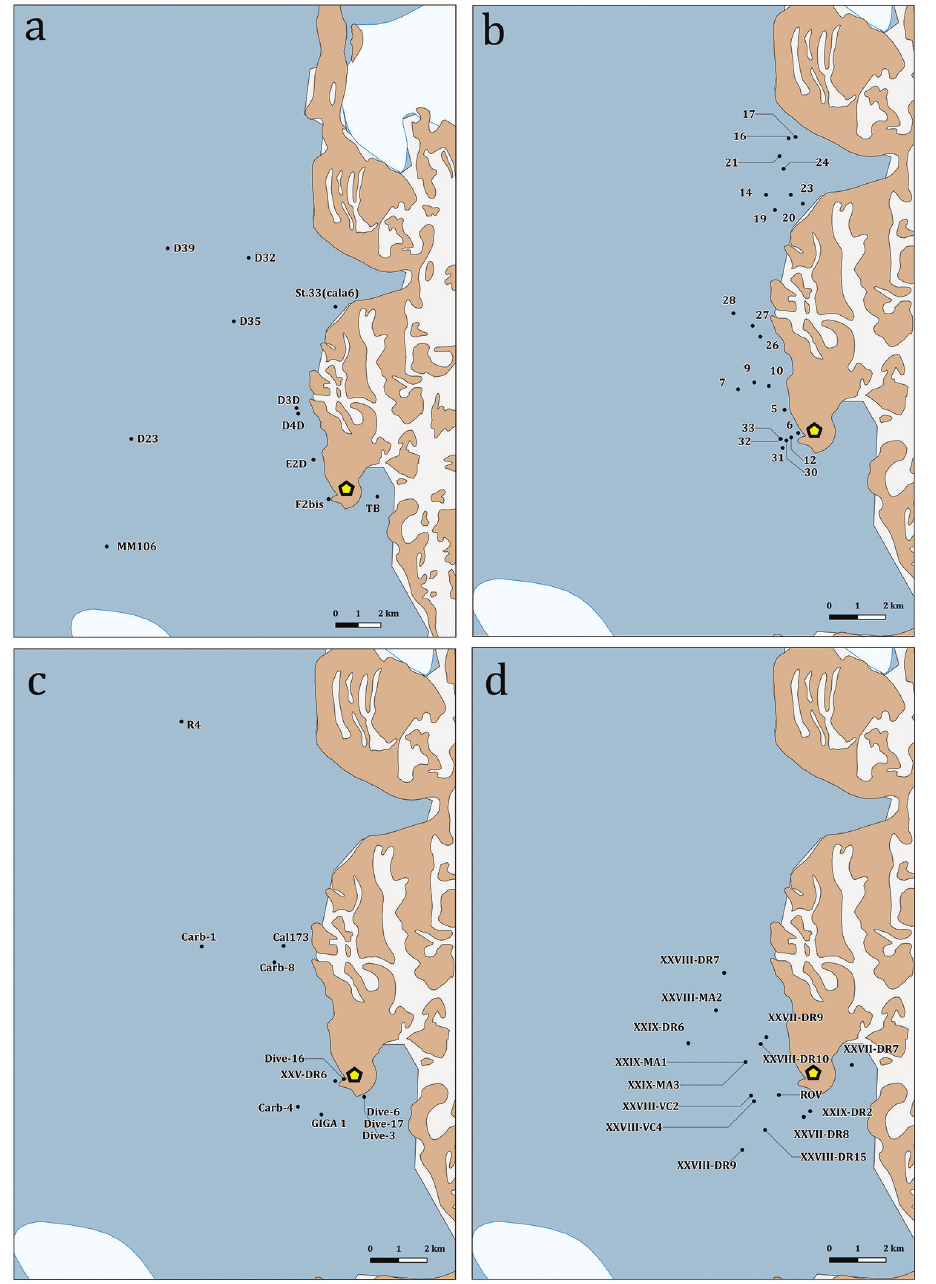
Figure 4. Detailed map of the sampling stations of the PNRA expeditions III, V and XI ( a ); XVIII ( b ); XIII, XIX, XVII and XXV ( c ); XXVII, XXVIII and XXIX ( d ). The yellow pentagon indicates the location of the research station “Mario